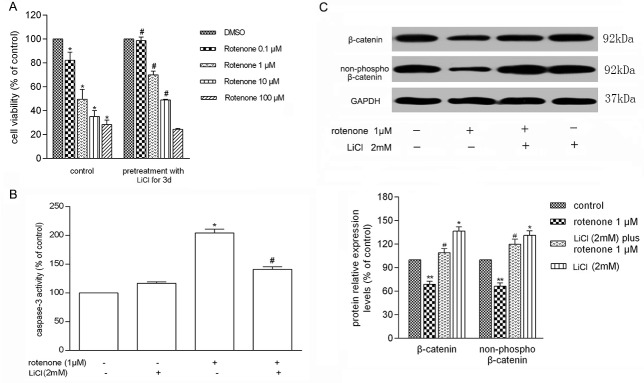
LiCl activated Wnt/β-catenin pathway for the survival of PC12 cells.PC12 Cells were pretreated with 2 mmol/L LiCl for 72 hours or 7 days prior to 1 μmol/L (μM) rotenone exposure, respectively. A. LiCl attenuated rotenone-induced cell injury. The cell viability was assessed as a percentage relative to vehicle group (n = 6 per group) and means ± SD (*P< 0.05; #P< 0.01 compared to equivalent rotenone treated group). B. LiCl inhibited caspase-3 activity in PC12 cells (*P< 0.05; #P< 0.05 compared to rotenone treated group). C. LiCl reversed the down-regulation of Wnt3a, β-catenin and non-phospho-β-catenin induced by rotenone (*P < 0.05; **P < 0.01 compared to vehicle; #P < 0.05 compared to rotenone treated group). All data are presented as means ± SD from three independent experiments.